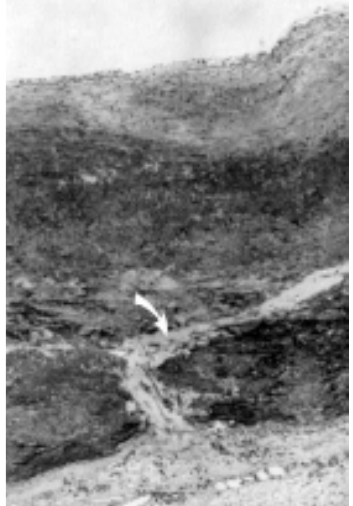
Fig. 1 - Transversal histological section of the ascending artery of a 32-year-old male patient with Marfan’s syndrome. Note the complete structural disorganization of the media layer, with intense fragmentation of the elastic tissue and great accumulation of mucopolysaccharides (blue arrow) and cystic fibrosis of the media. Staining method: Movat pentachromic stain. Magnification: 100